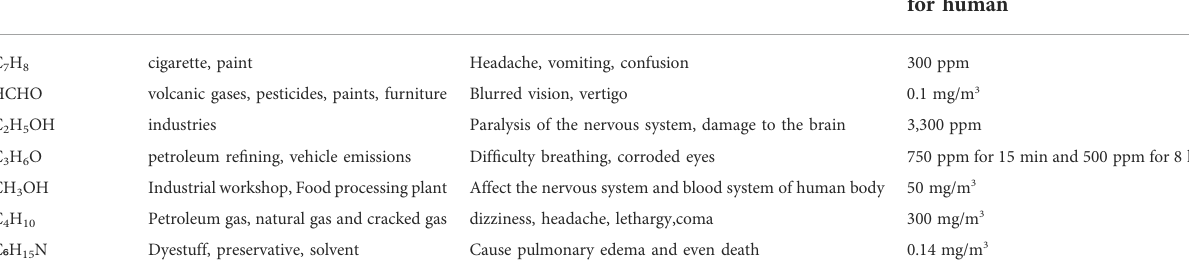
TABLE 1 Effects of various VOCs on